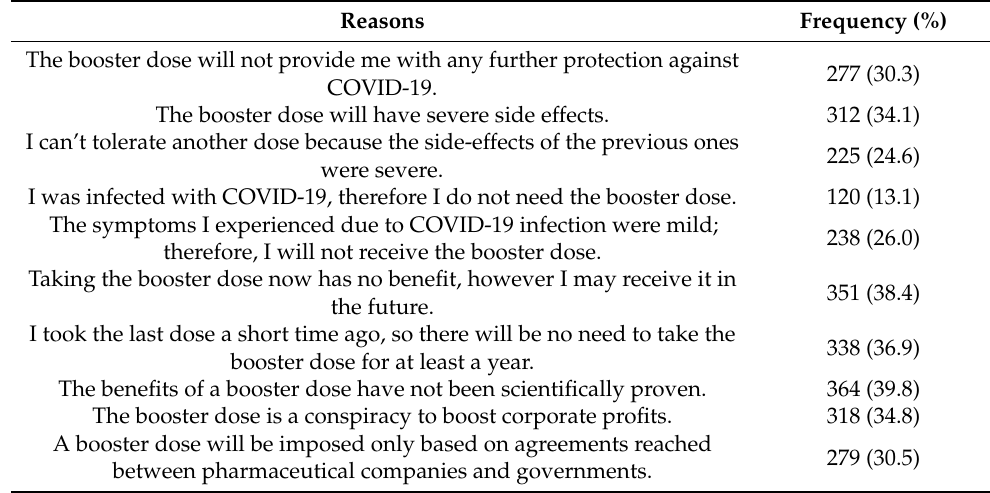
Table 4. Reasons participants provided for responding “No” or “not sure” regarding intent to get a booster dose of the COVID-19